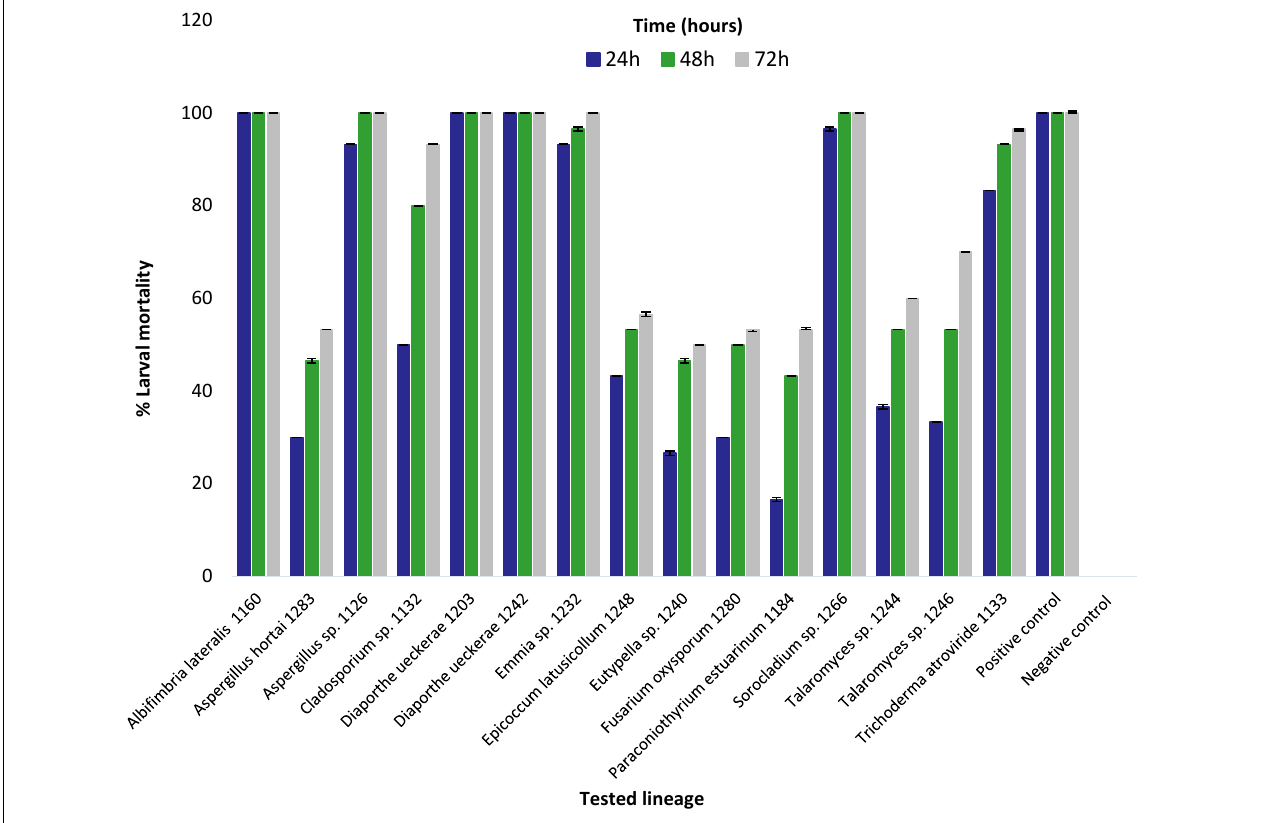
FIGURE 1 | Percentage of mortality of 3rd instar Aedes aegypti larvae exposed to liquid medium extracts obtained from strains of fungi isolated from Amazonian aquatic environments. Mortality was assessed after 24, 48, and 72 h of exposure to fungal extract at a concentration of 500 µ g/ml. Error bars represent standard deviation. Positive control (Temephos) and Negative control (dimethyl